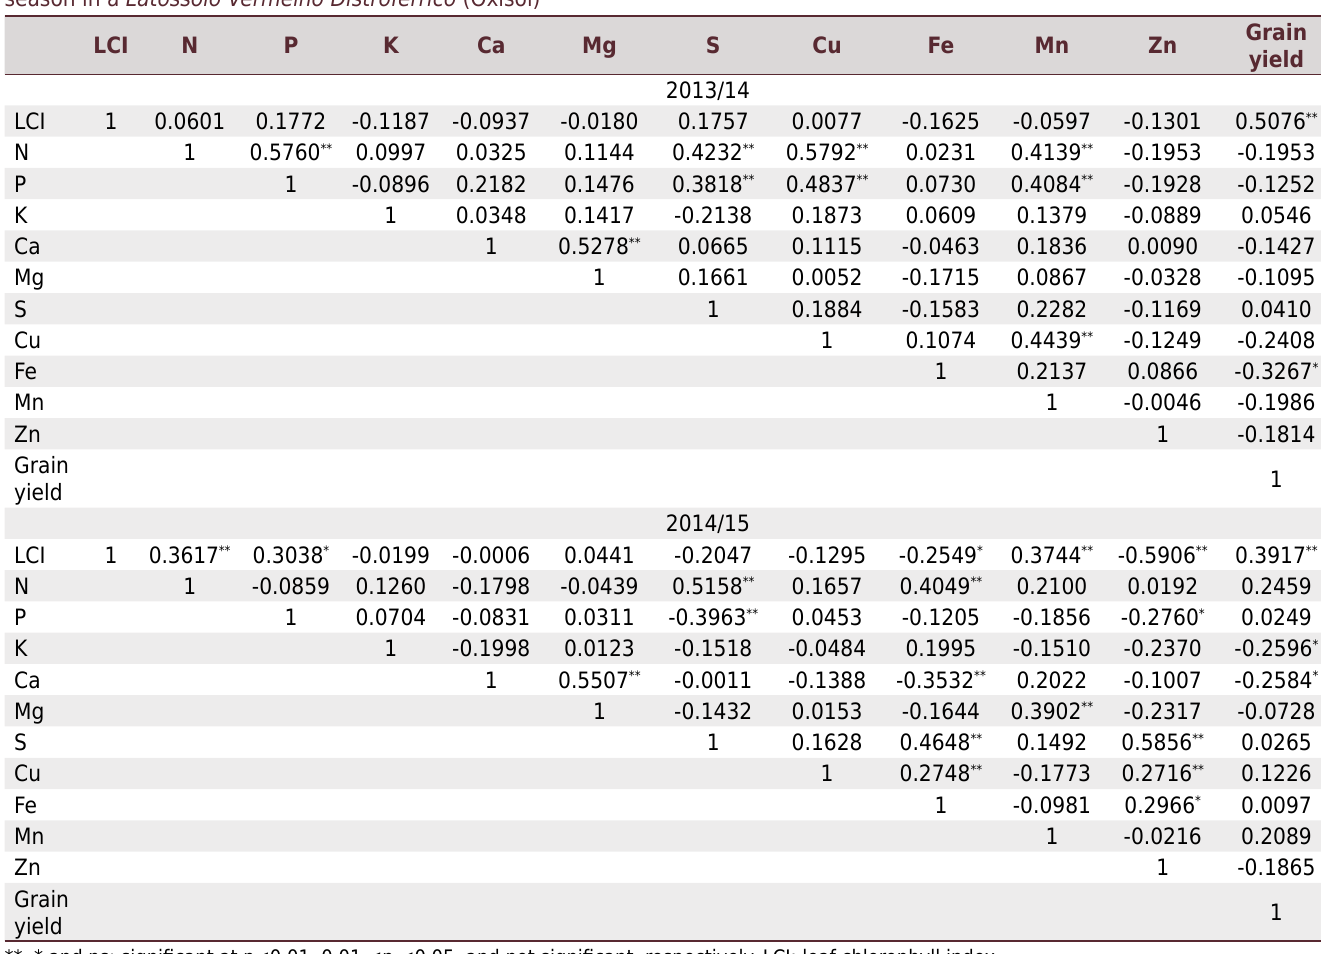
Table 6. Pearson correlation coefficients among leaf nutrient concentrations and corn grain yield in the 2013/14 and 2014/2014 crop season in a Latossolo Vermelho Distroférrico